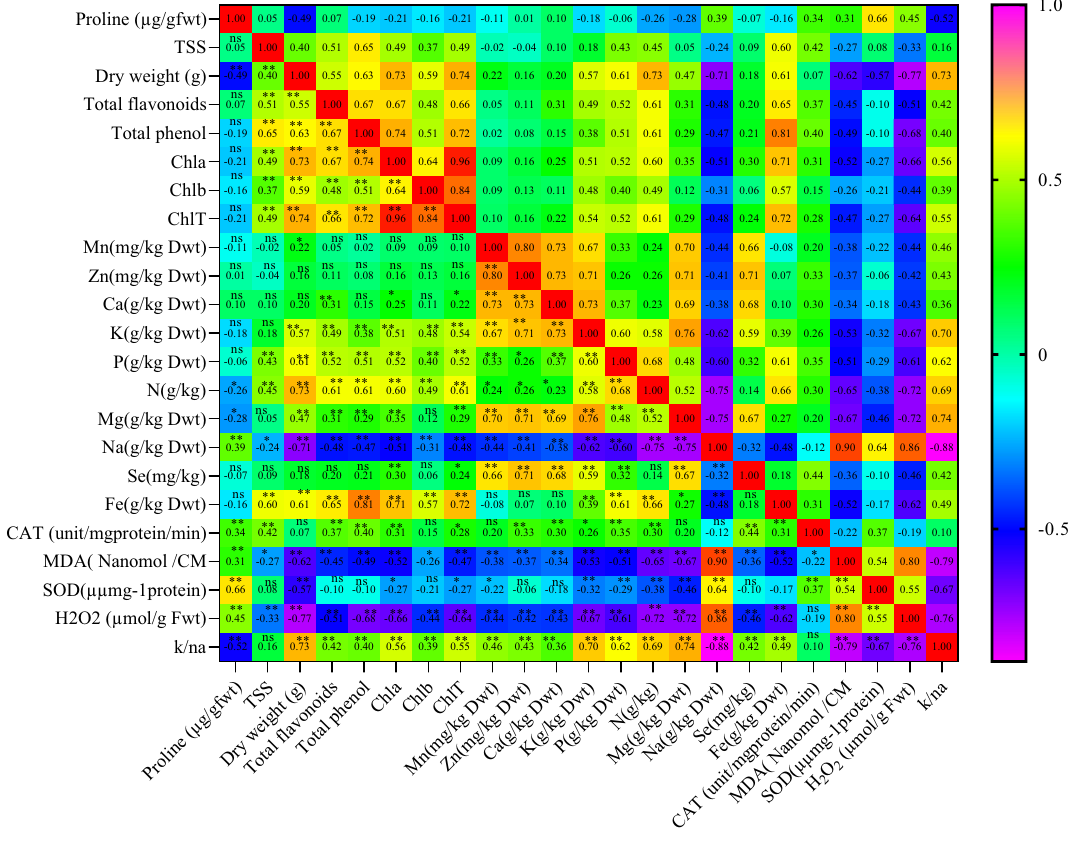
Figure 5. Pearson correlations among evaluated traits of grapevine cv. Sultana under salinity and treated by Se and nano Fe. **, * and ns correlation were significant at 1% and 5% of probability level and non-significant, respectively. TSS (total soluble solids), Chl a (chlorophyll a), Chl b (chlorophyll b), Chl T (total chlorophyll), CAT (catalase activity), SOD (superoxide dismutase activity), MDA (malondialdehyde